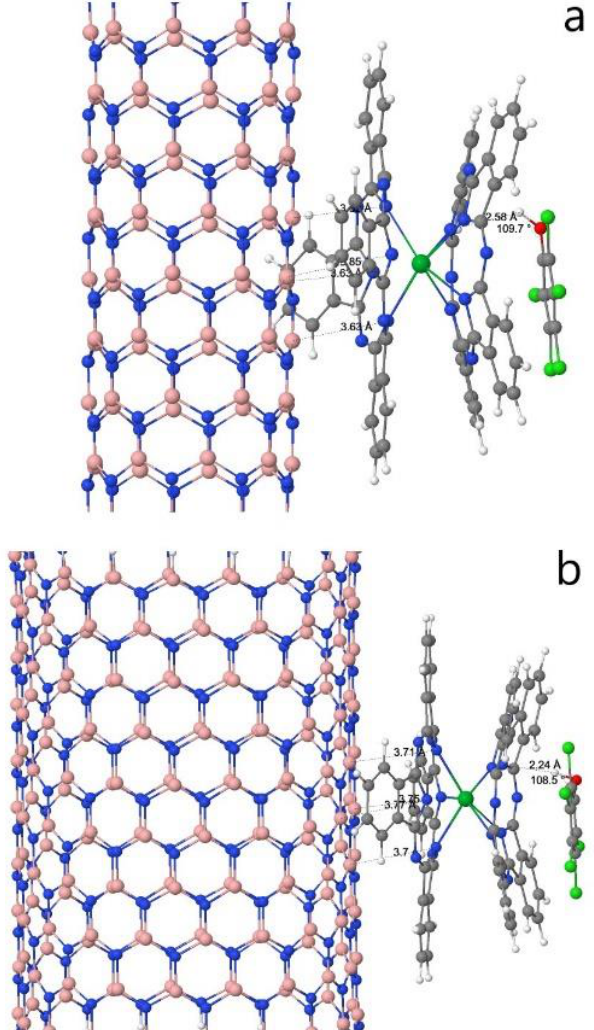
Figure 3. Equilibrium structures of pentachlorophenol (pcp) adsorbed on the zigzag ( a ) (9,0) and ( b ) (18,0) boron nitride nanotubes decorated with YbPc 2 complex.